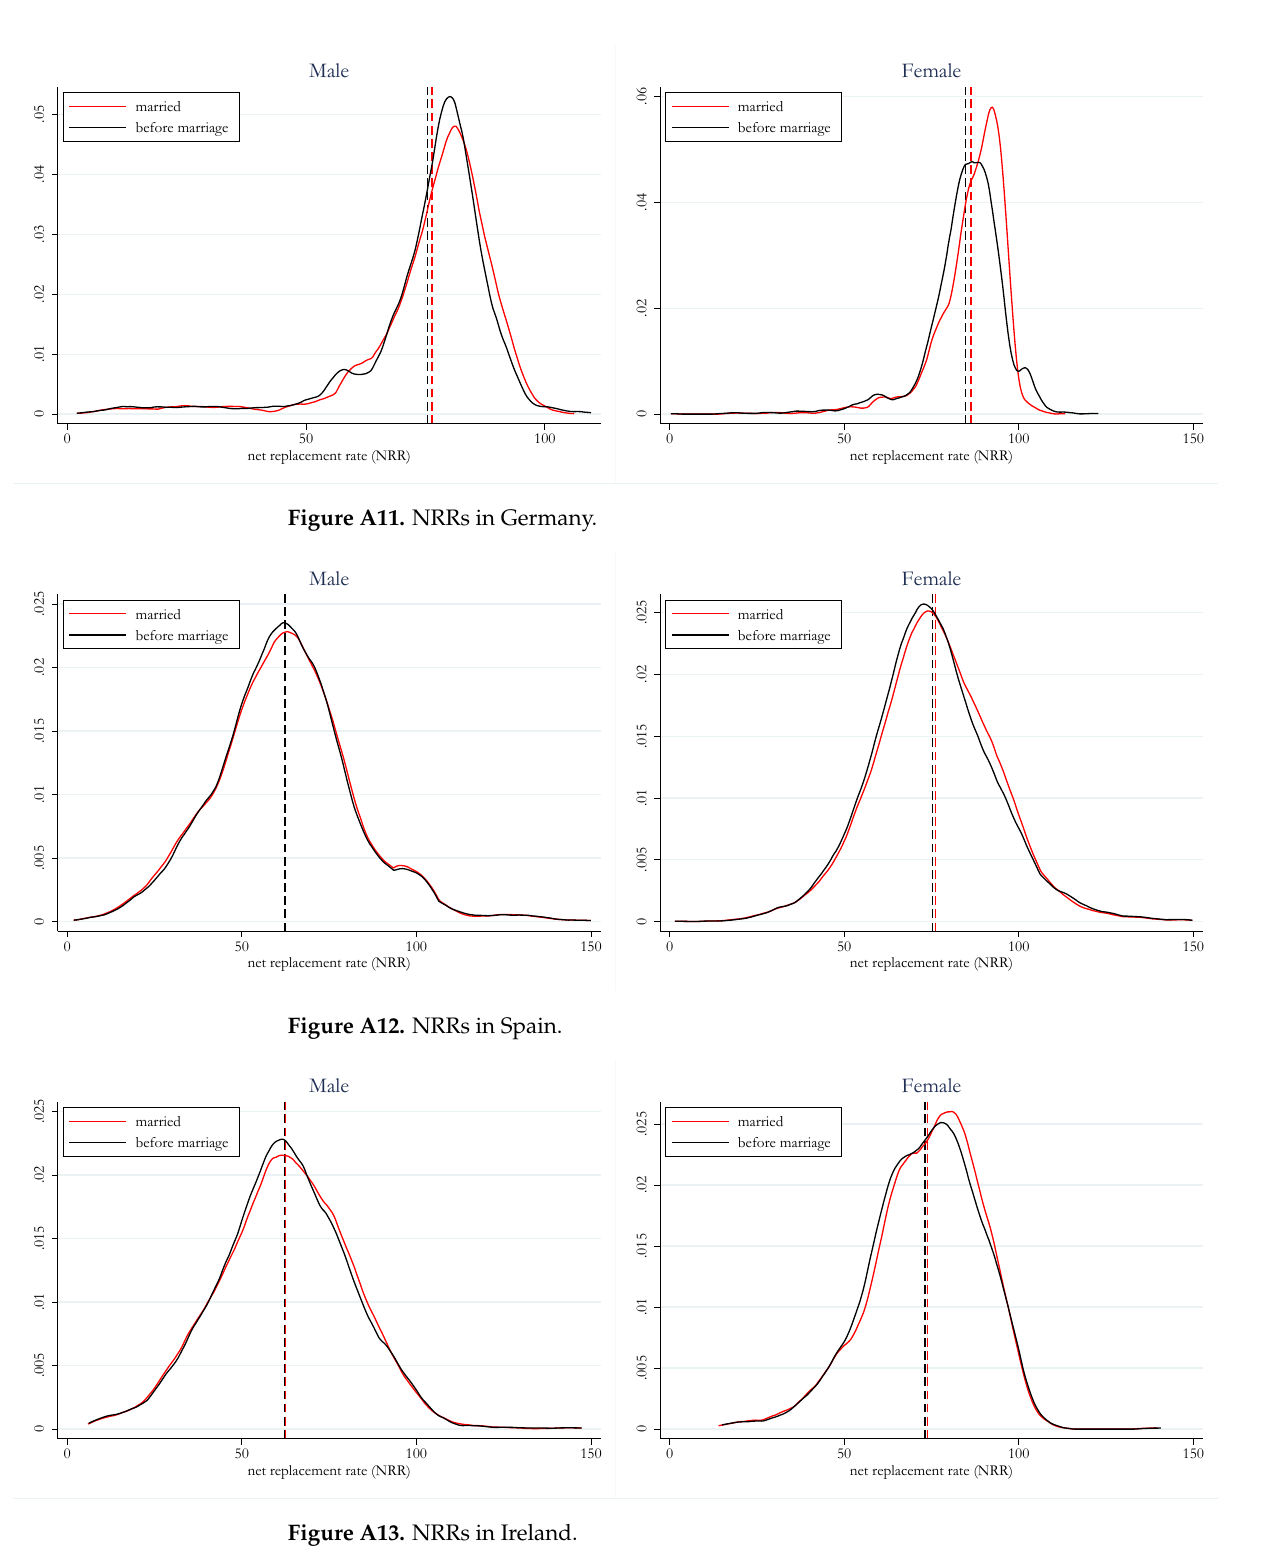
Figure A13. NRRs in